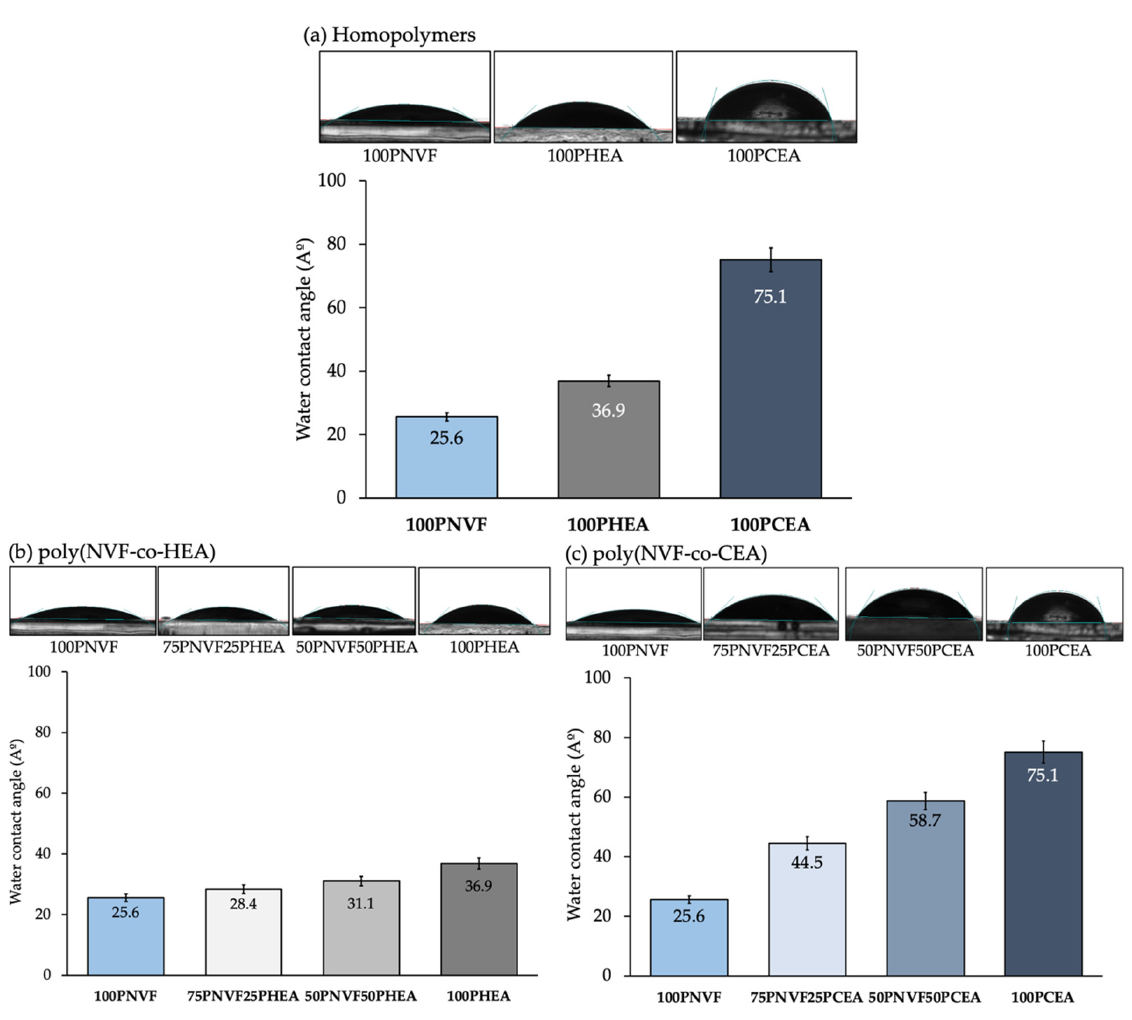
Figure 1. Contact angle of the homopolymer hydrogels ( a ) and PNVF-copolymer hydrogel series: ( b ) P(NVF-co-HEA) and ( c ) P(NVF-co-CEA). The corresponding images of water droplets are depicted for each composition. Table 1. Compositions of homo- and copolymers hydrogels based on